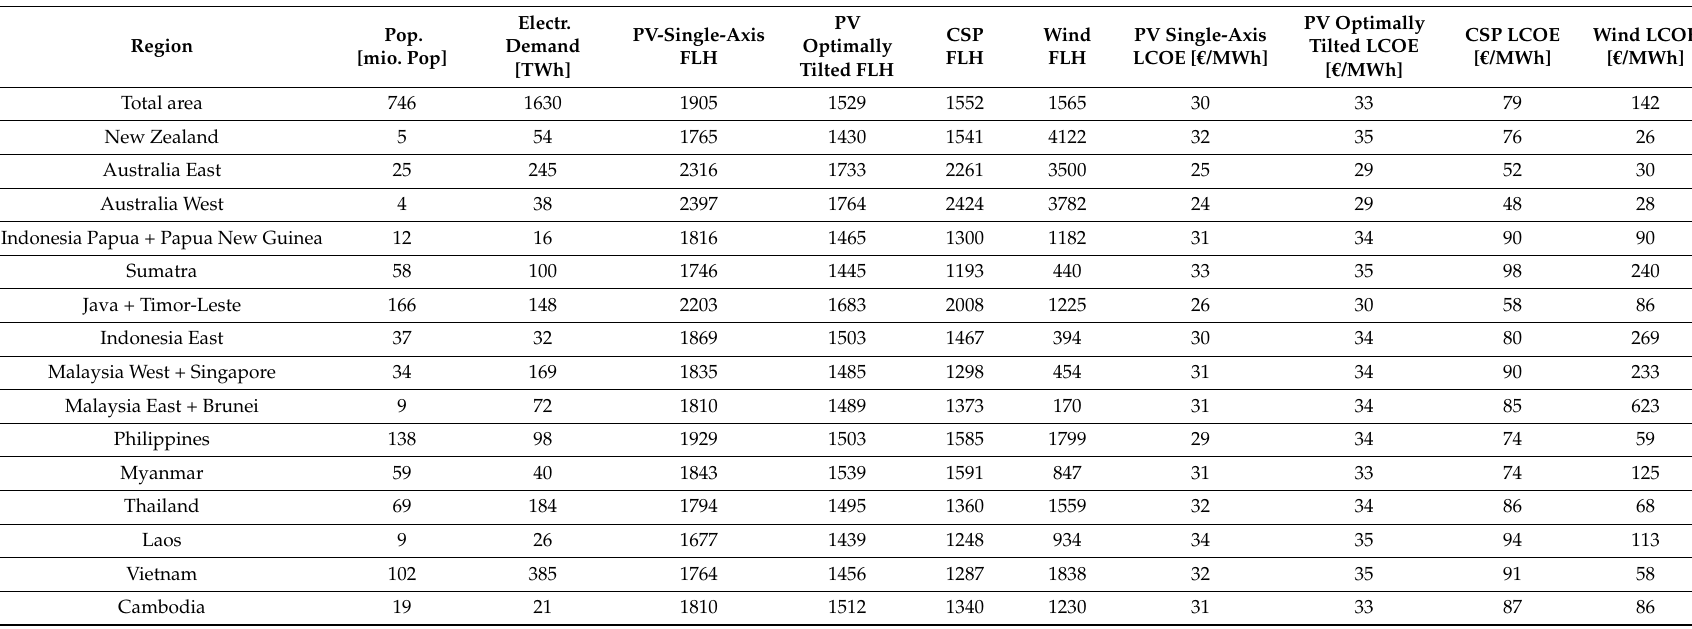
Table 3. Average full load hours and levelized cost of electricity (LCOE) for single-axis tracking PV, optimally tilted PV, solar CSP and wind power plants in Southeast Asian regions. Pop.: population; mio.: million; Electr.: electricity and FLH: full load hours.